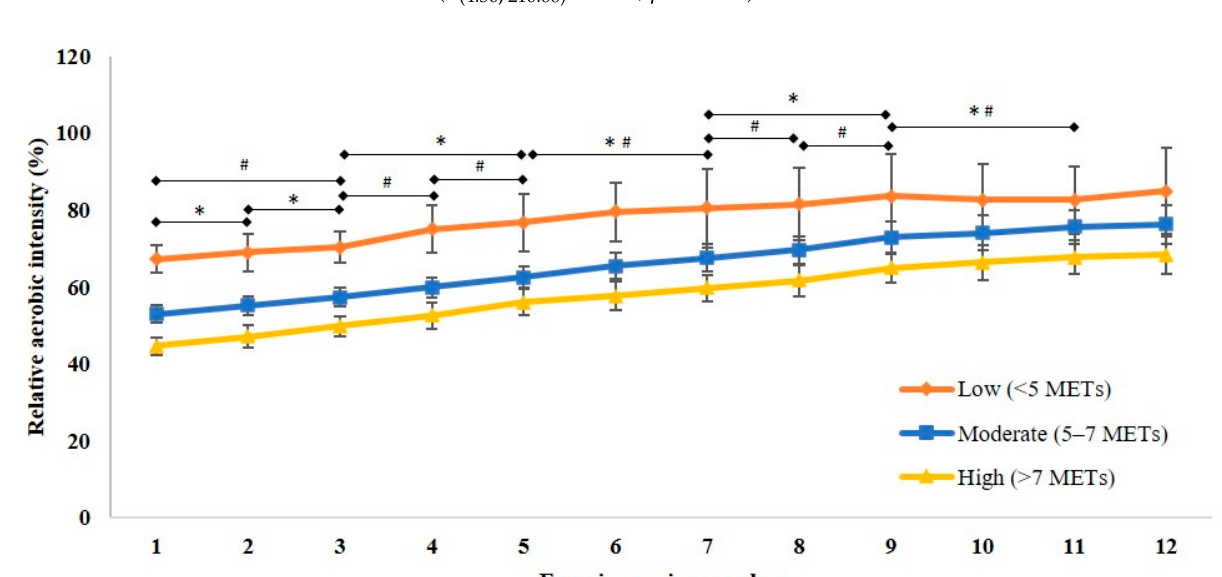
Figure 3. Relative (to initial physical capacity) aerobic exercise intensity prescribed to patients with different initial physical capacity during 12 sessions of cardiac rehabilitation. Data presented as mean (95% CI). * Significant progression in relative aerobic intensity for high initial physical capacity, # significant progression in relative aerobic capacity for high initial physical capacity. METs—metabolic equivalents.